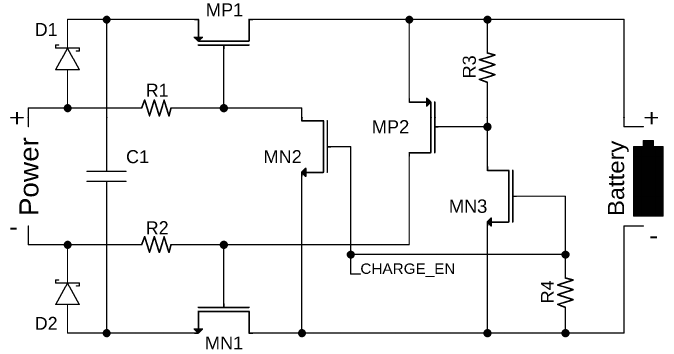
Figure 5. Schematic of the battery charging unit.